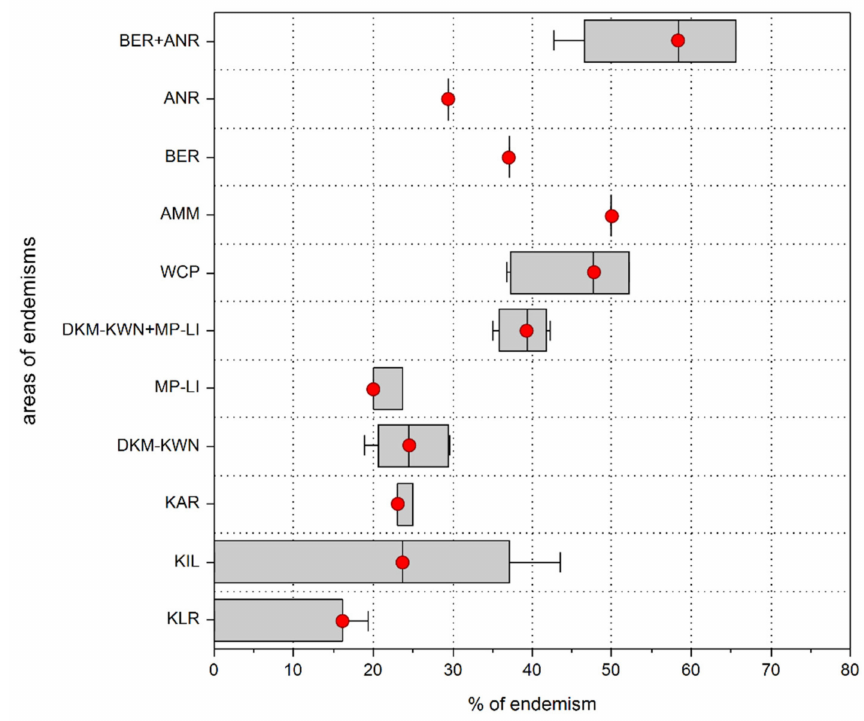
Figure 10. Box plots of the ratio “number of endemic species/total of species” for each of the AoEs identified by the DBSCAN analysis. Red spot = median.